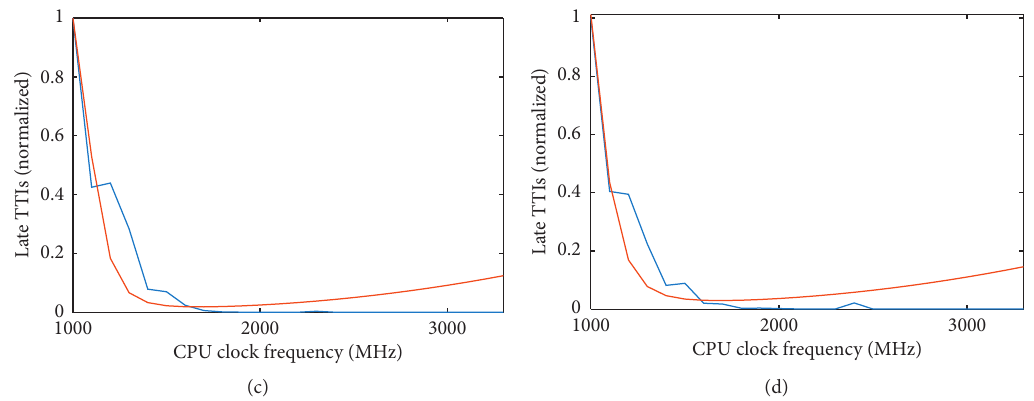
Figure 10: System 2: comparison of actual and predicted lates for f bandwidth. (b) 10MHz bandwidth. (c) 15MHz bandwidth. (d) 20MHz bandwidth.